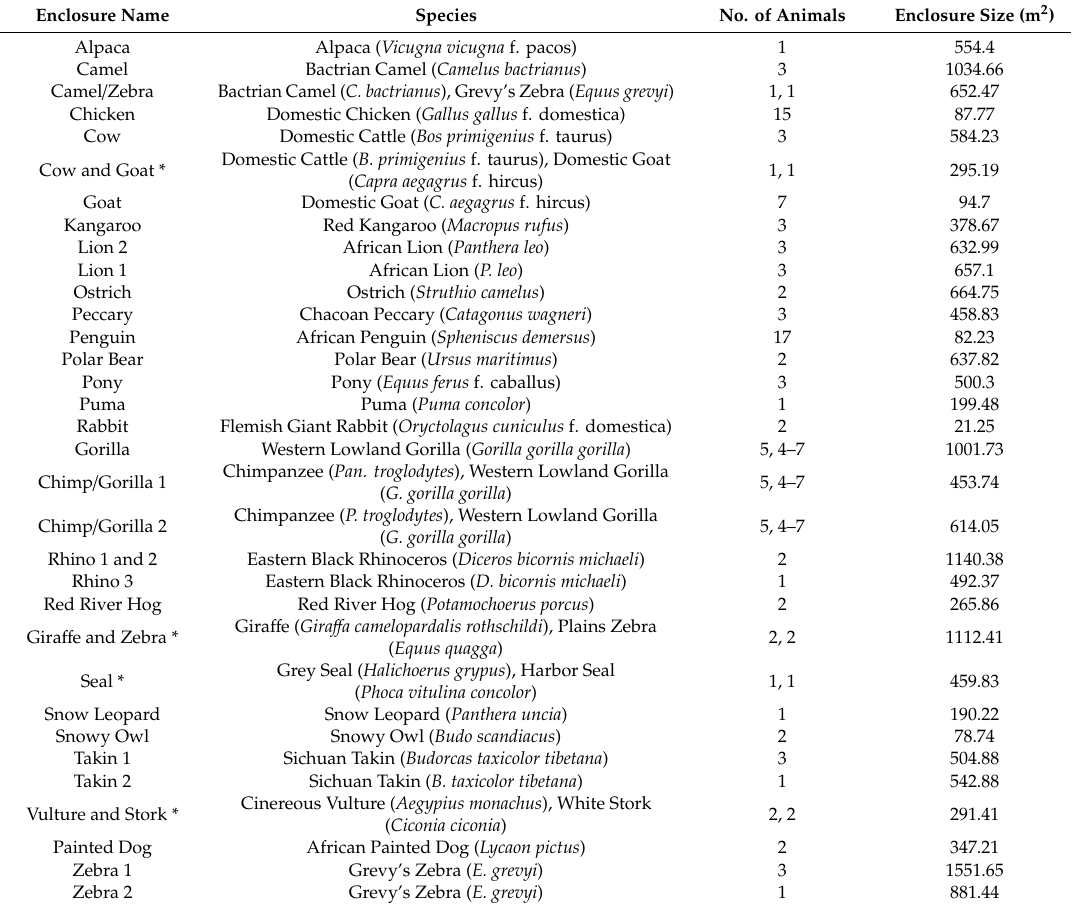
Table 1. Outdoor enclosures at Lincoln Park Zoo with shade assessments in this study. Domesticated species are presented as “forms” as per Zeller and Göttert